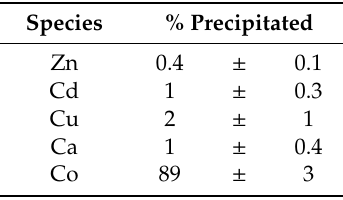
Table 9. Composition (%) of the produced cobalt hydroxide and specifications for the feed of a custom cobalt